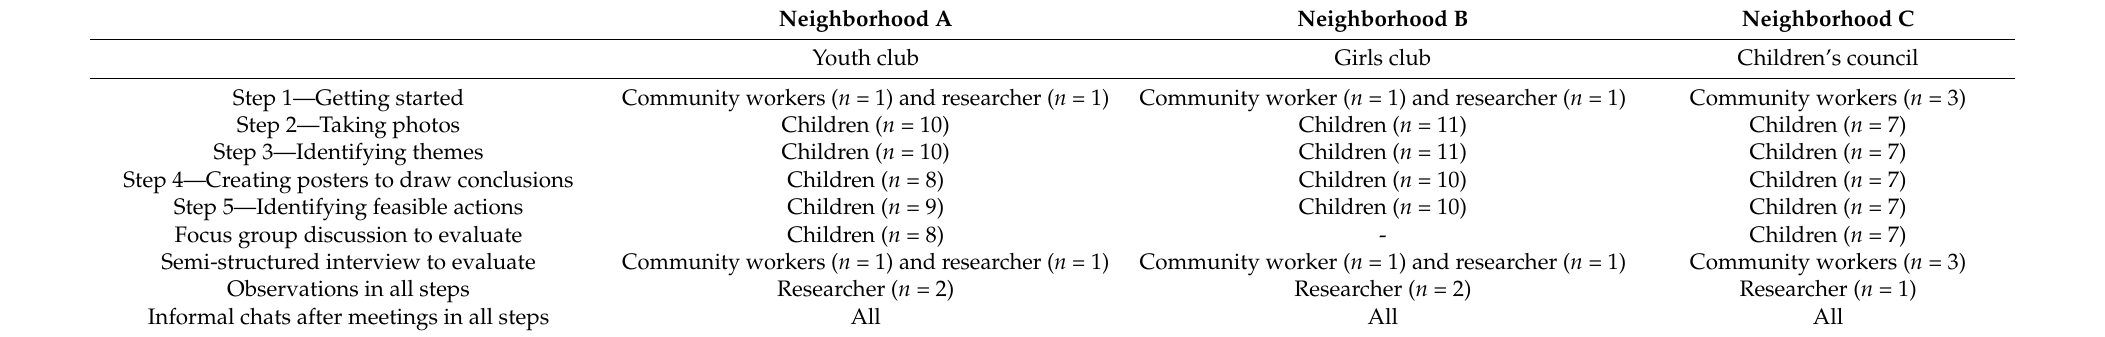
Table 3. Participants in the different types of data